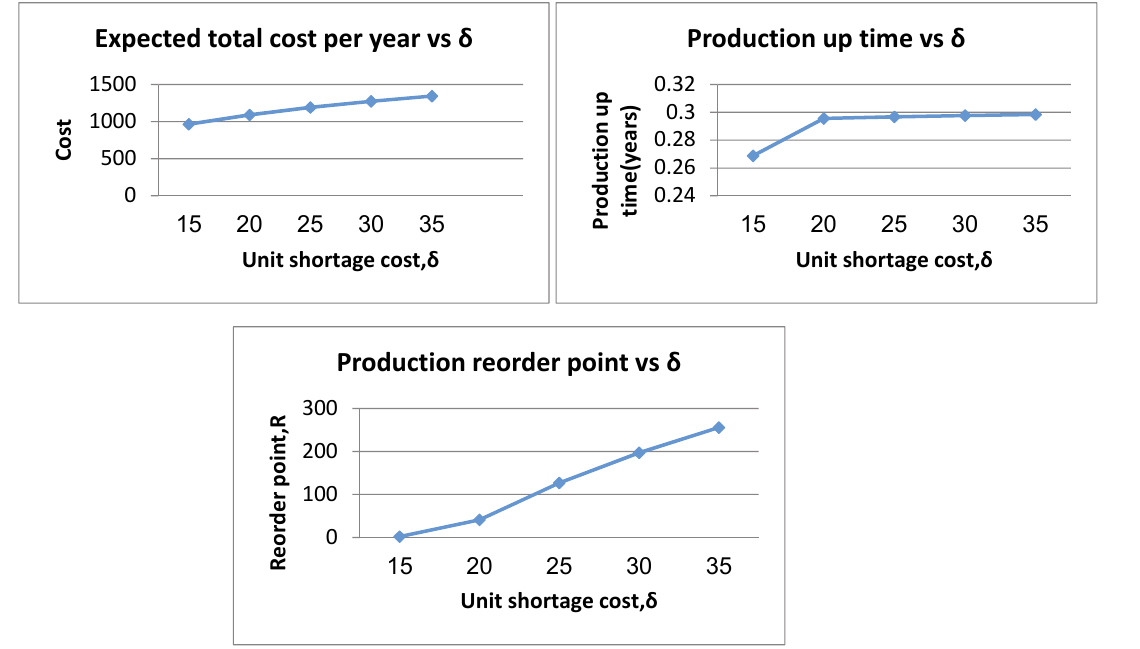
Fig. 10. Expected total cost per year, up time & reorder point for different value of